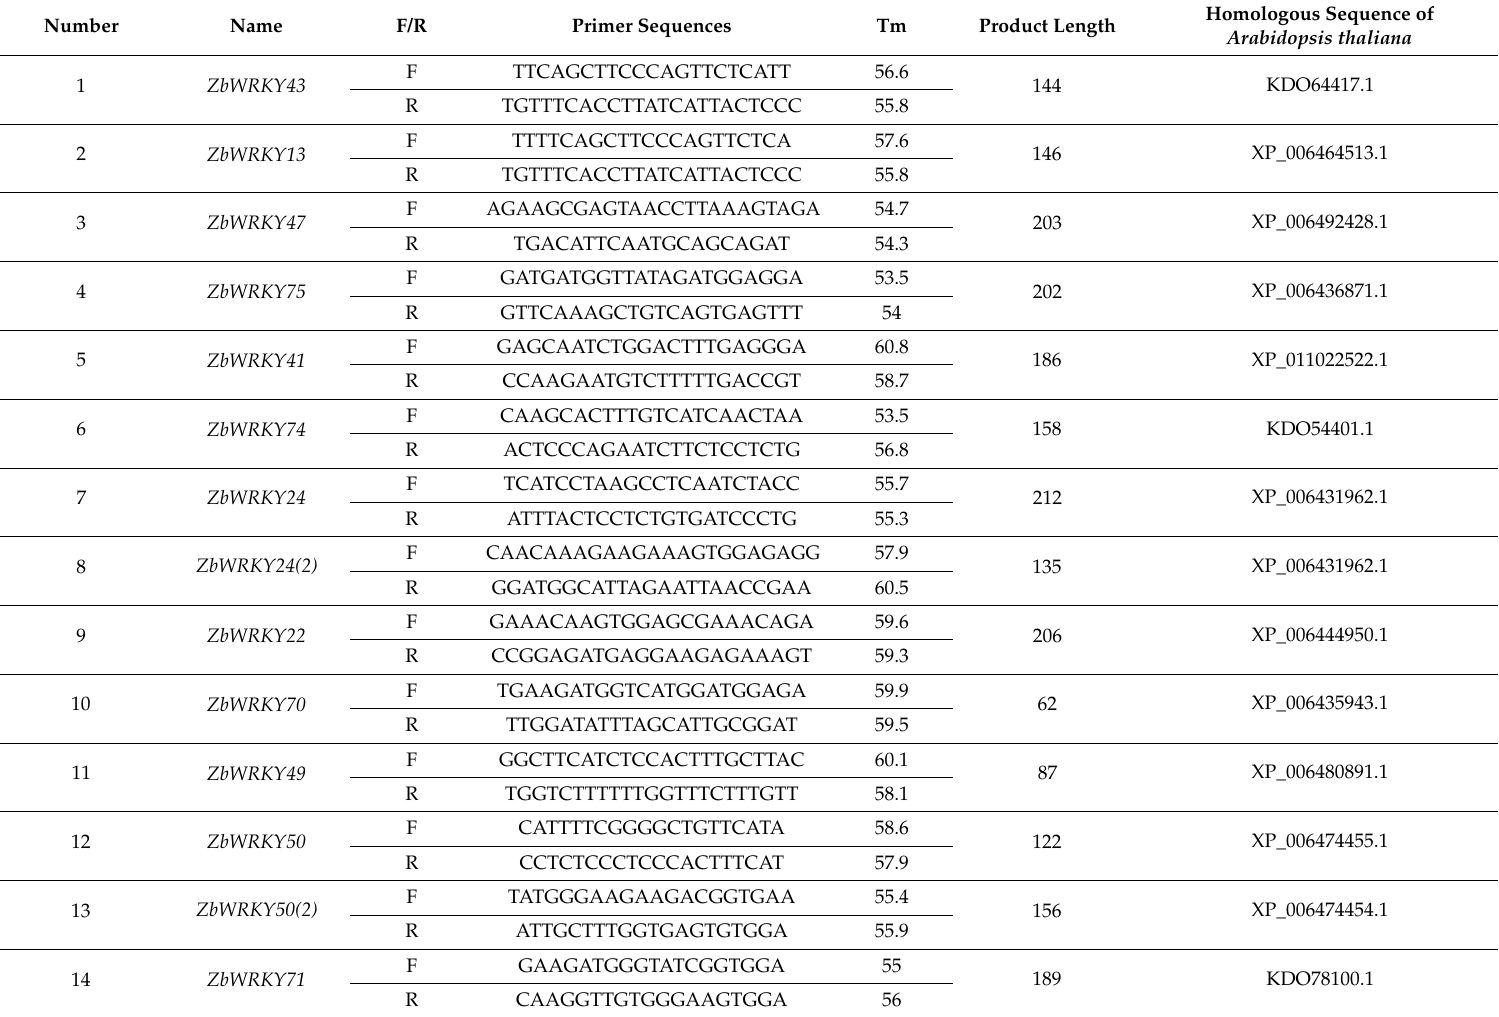
Table 2. Primers for real-time quantitative